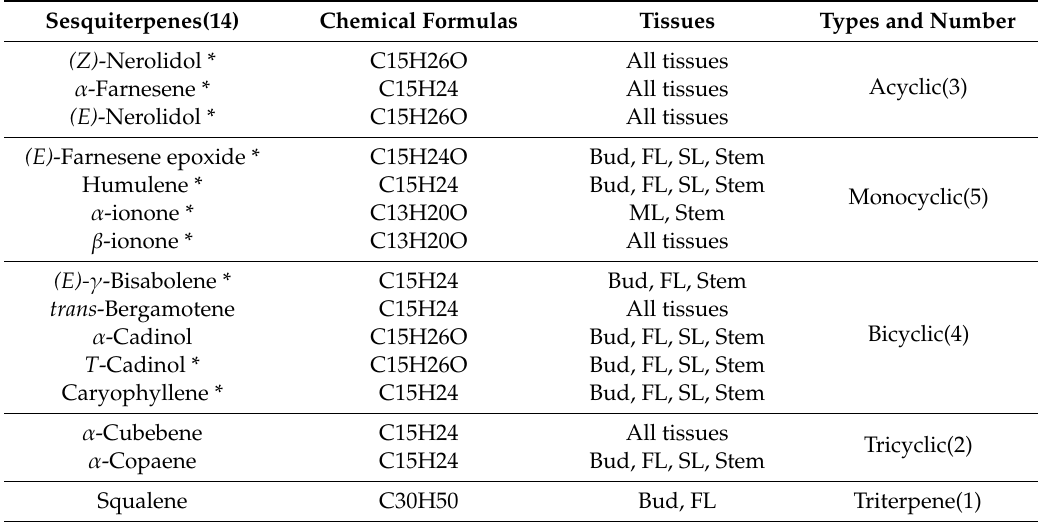
Table 2. Sesquiterpenes and triterpenes detected in tea